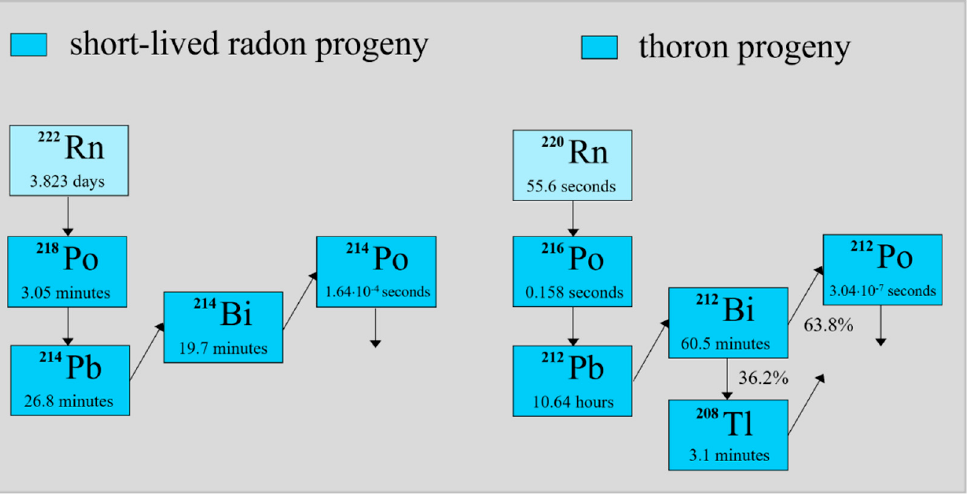
Figure 1. Radon and thoron decay products and their half-lives.